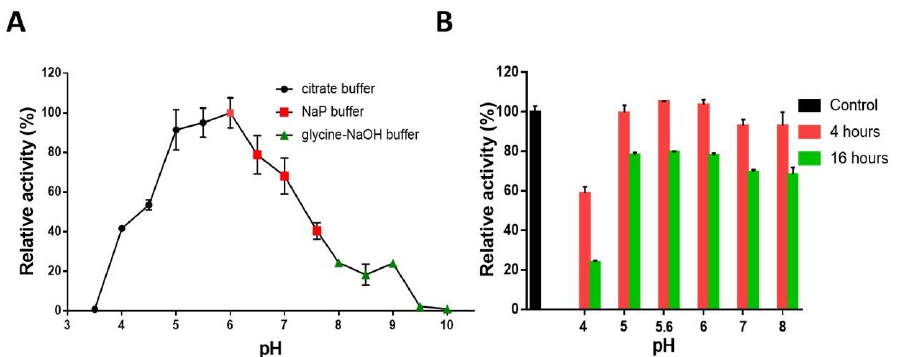
Figure 5. Effect of pH on activity ( A ) and stability ( B ) of AmCel9. ( A ) Black dots indicate the percentage of activity in citrate buffer (pH from 3.5 to 5.5); red squares in Na-P buffer (pH from 6 to 7.5) and green triangles in glycine-NaOH buffer (pH from 8 to 10). ( B ) Relative activities at the optimal pH 6 without incubation (control, black), and after 4 and 16 h of incubation at different pH values (red and green, respectively).